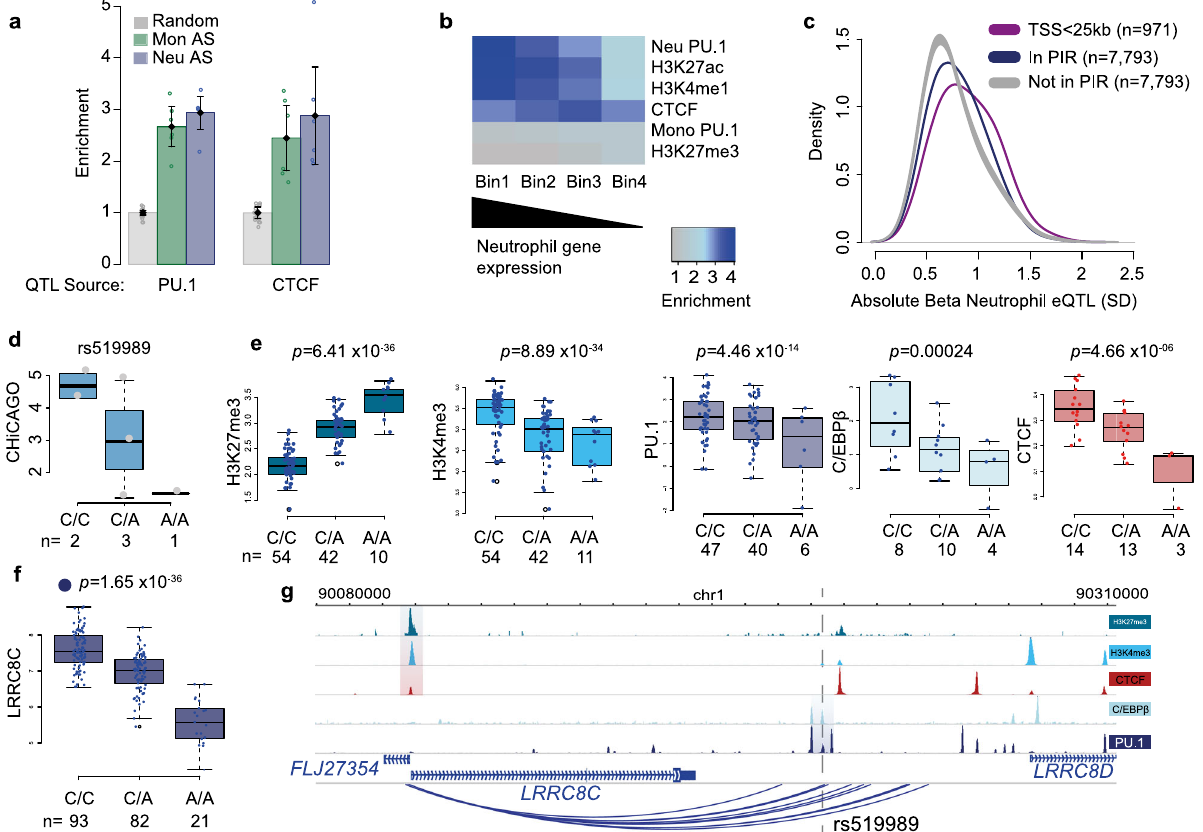
Fig. 4 tfQTLs perturb gene expression through altered chromatin state. a Enrichment of signi fi cant tfQTLs (PU.1 and CTCF; Fisher ’ s exact test p <1 ×10 − 5 ) in PIRs of both neutrophils and monocytes. The bars represent the mean and the error bars the 95% con fi dence interval. b Heat map showing enrichment of transcription factor or histone modi fi ed regions intersecting PIRs, whereby PIRs were ranked into four bins based on the gene expression of the connected baited genes in neutrophils. c Density plot of gene expression QTL Beta value for neutrophil PU.1 SNPs within PIRs (navy) versus distance-matched signi fi cant SNPs not in PIRs (grey) (two-sided Fisher ’ s exact test p <2× 10 − 16 ), and distribution of beta values for SNPs within <25kb of transcription start site (purple). The SNPs that are not in PIRs are also signi fi cant PU.1 tfQTLs and eQTLs (linear model p < 1×10 − 5 cut off). d CHiCAGO scores for the PIR at tfQTL, segregated by donor genotype for rs519989. n the number of individual donors. e Signal box plots with donors separated by genotype for rs519989 for fi ve molecular traits, f boxplots displaying RNA level for LRRC8C gene segregated by donor genotype for SNP rs519989. n = the number of individual donors. Box plots show the medians (centre lines) and the 25th and 75th percentiles (box edges), with whiskers extending to 1.5 times the interquartile range. p values were obtained by fi tting linear mixed models implemented in LIMIX. g Genome browser view of region around LRRC8C gene, QTL regions for each molecular trait are highlighted. Dashed line depicts the location of